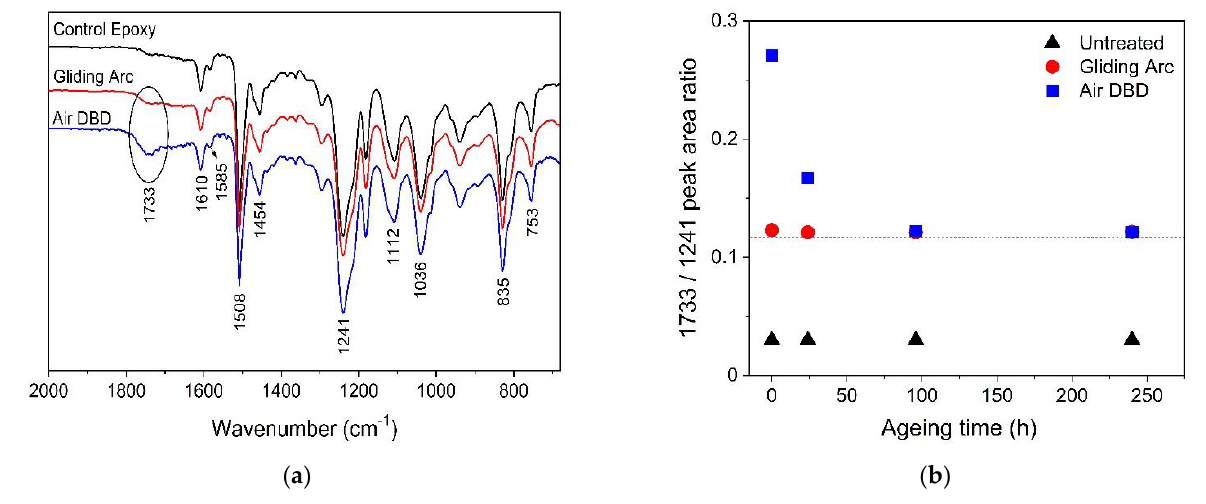
Figure 4. ( a ) FTIR spectra and ( b ) variation of 1733/1241 FTIR peak area ratio with storage time of untreated and atmospheric plasma treated epoxy samples with Gliding Arc and Air DBD reactors.